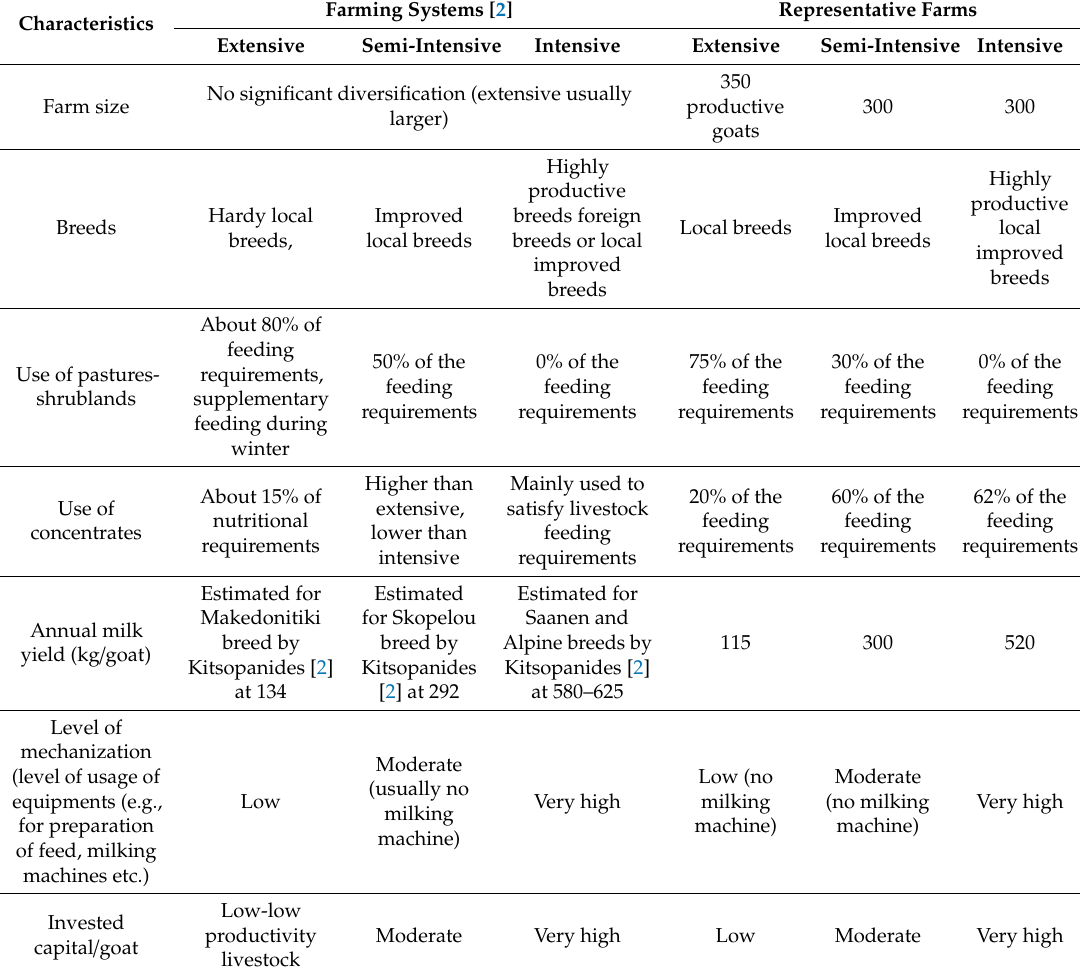
Table 4. Main Characteristics of the production systems identified in Greece and of the representative farms used in the